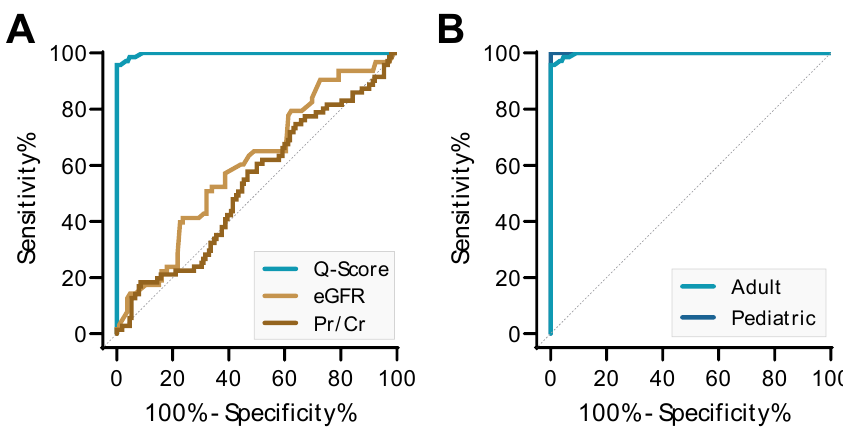
Figure 4. Q-Score performance compared to serum creatinine (SCr) and the estimated glomerular filtration rate (eGFR) and by recipient age. ( A ) The Q-Score showed superior performance compared with SCr and eGFR in discriminating AR from STA. ( B ) The performance of the Q-Score in different transplant patient age groups to differentiate AR from STA. Q-Score performed equally well in diagnosing pediatric transplant recipients (10 months to 18 years old) and in adult transplant recipients >18 years old. The AR prediction AUC of the ROC for pediatric patients was 100% (95% CI: 1.000–1.000; STA 25, AR 4) and the AUC of the ROC for adult patients was 99.8% (95% CI: 0.995–1.000; STA 127, AR 67).